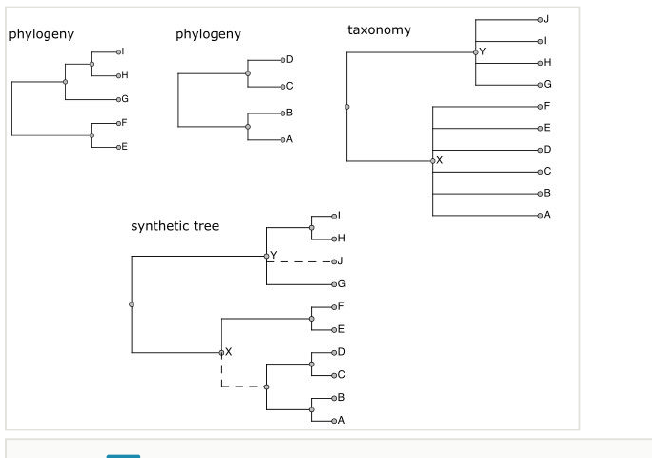
Figure 1. Role of taxonomy in assembly of the Open Tree of Life synthetic phylogenetic tree. Dotted lines in the synthetic tree are those that come only from taxonomy, while solid lines have phylogenetic support. The taxonomy both links disjoint phylogenies and adds taxa not present in input